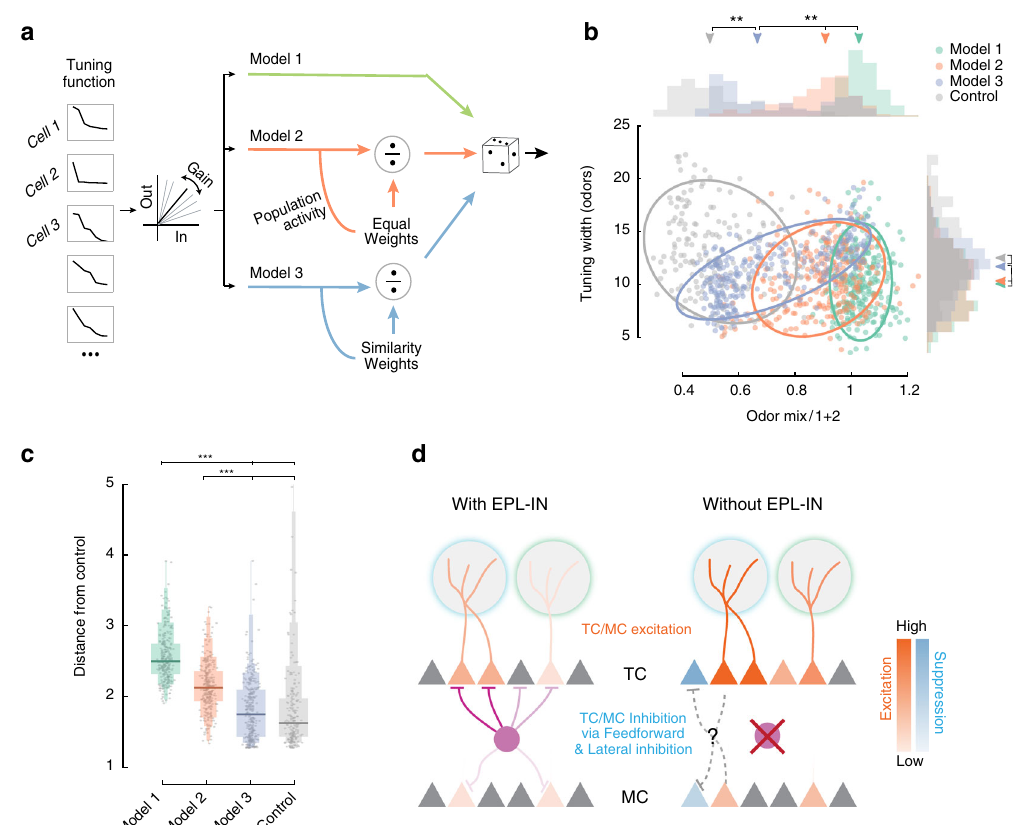
Fig. 8 Model of the TC responses. a Schematic of three LNP models used to generate the simulated responses (see “ Methods ” section). b Scatter plot of tuning width as in Fig. 5f (right histogram with arrows representing medians) and activity ratio of odor mixtures as in Fig. 7b (top histogram with arrows representing medians), for the three models compared to the tuning width of the TCs in Control animals (gray). n = 300 for all three models and n = 199 for control data. Ellipses represent the 80 th percentile con fi dence intervals. Note that for visibility purposes only data within 3 standard deviations from the median are included in the scatterplot. * p < 10 – 5 , ** p < 10 – 18 , one-sided two-sample Kolmogorov – Smirnov test. c Average mahalanobis distances in ( b ) between each of the cells of model/control performance and the control data. Lines indicate the median of the distribution, and the variable bars indicate the 75, 90, 95, and 100 percentiles. Dots represent the d ’ for each unit ( n = 300 for all three models). *** p < 10 – 24 , Wilcoxon rank sum test. d Schematic of the proposed connectivity and function of EPL-INs in the olfactory bulb. Model shows preferential changes in TC odor responses upon genetic silencing of